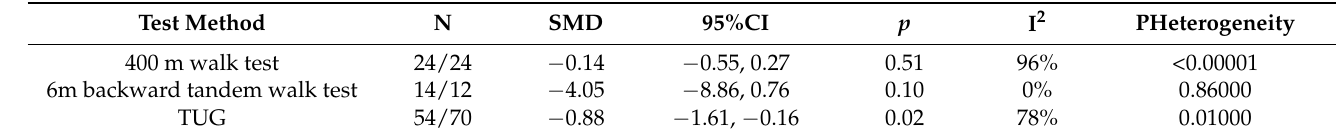
Table 3. A subgroup analysis of the effects of low intensity resistance training with blood flow restriction on walking ability in middle-aged and older adults.